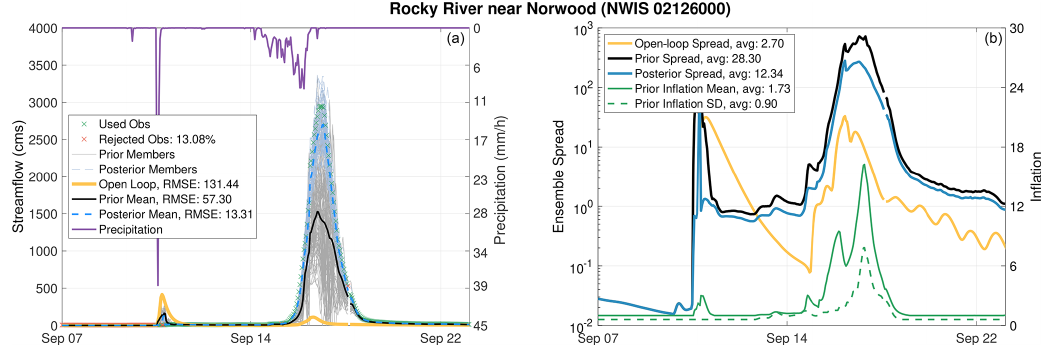
Figure 12. (a) Open-loop, prior, and posterior hydrographs obtained at the Rocky River near Norwood. Precipitation rates computed at that gauge are plotted according the right y axis. (b) Open-loop, prior, and posterior ensemble spread (in cms) time series are displayed in log scale. The evolution of the prior inflation mean and standard deviation (SD) is also shown. RMSEs, average ensemble spread and average inflation mean, and standard deviation values are reported in the legends.